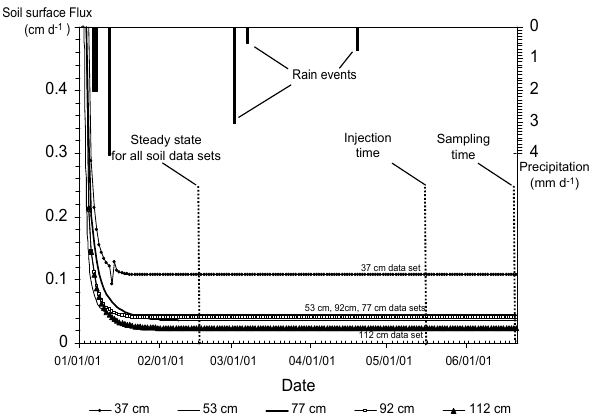
Fig. 5. Simulation of the steady-state establishment for five differ- ent van Genuchten soil parameters sets, assuming an initial satura- tion of soil profile from 0.50m to 2.44m depths at the beginning of the year 2001. Uprising fluxes computed with Hydrus 1D (right axis, cmd − 1 ) and rain events (left axis, mmd − 1 ). Boundary con- ditions reflecting: (i) meteorological data (rain events and potential evaporation of 5mmd − 1 and maximum suction head corresponding to 0.0495 water content at the upper cell (0.5m depth), (ii) Lower boundary condition fixed with water saturation at 2.44m depth. The top layer (0 to 0.5m depth) was not considered in the